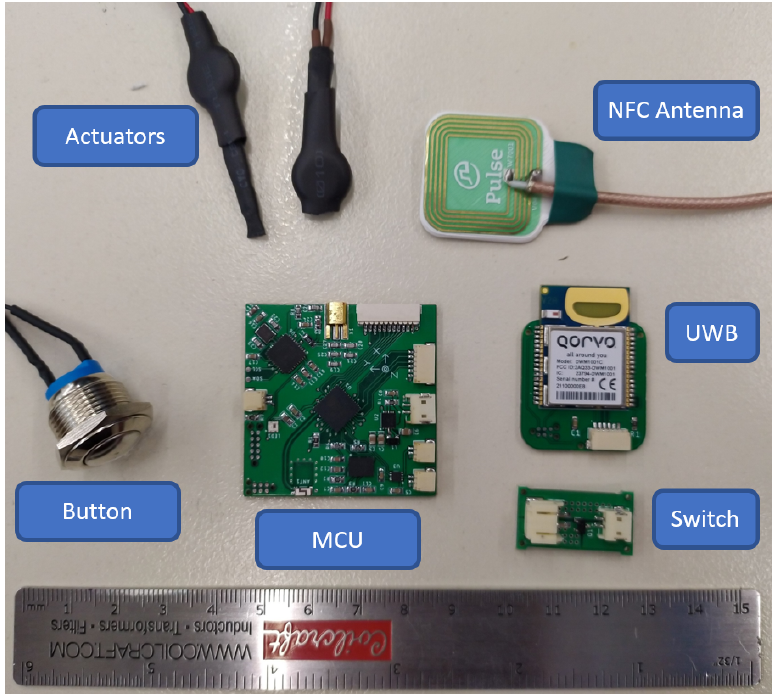
Figure 6. The final components to be included in the smart lifejacket. The MCU board also contains the NFC reader and the IMU.